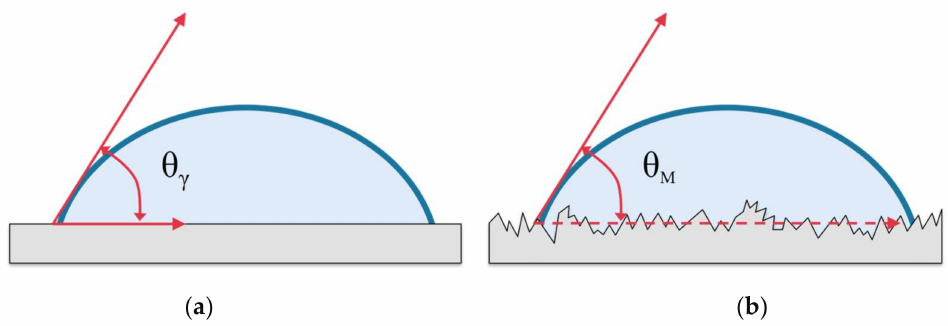
Figure 7. Wenzel model contact angle: ( a ) Flat surface; ( b ) Rough